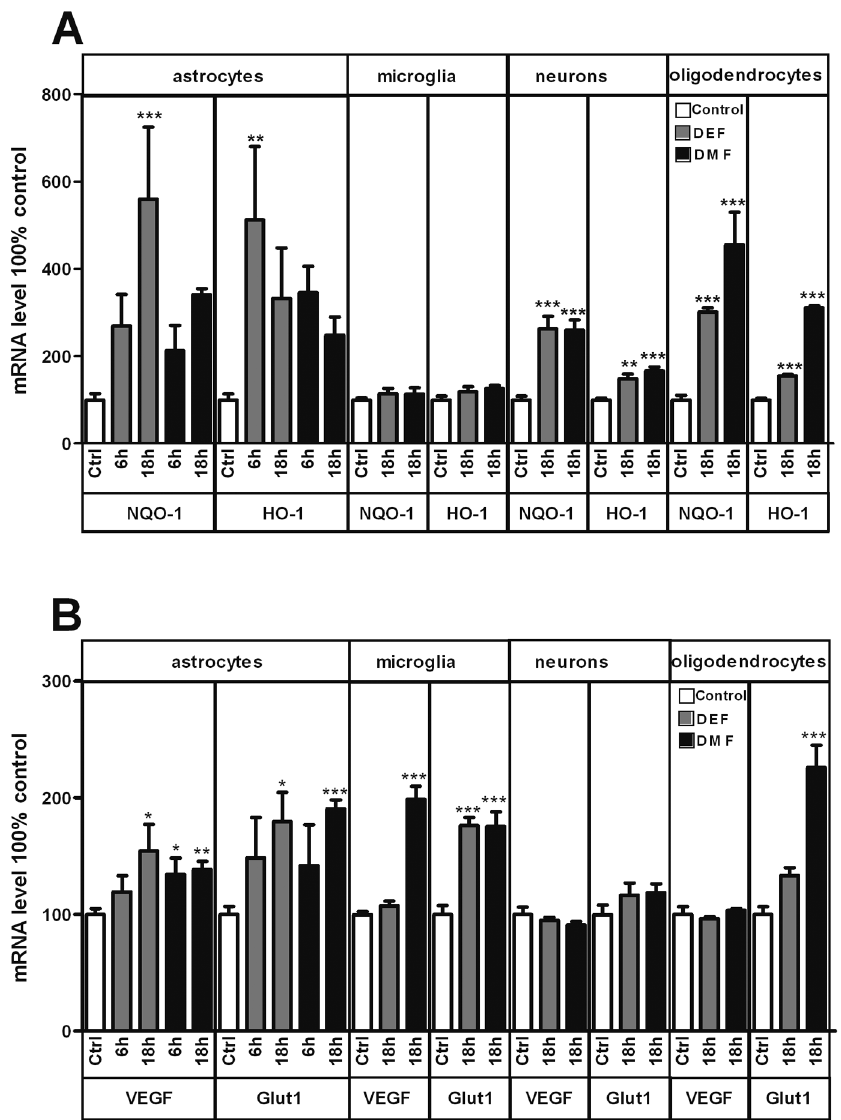
Figure 1. Transcriptional effects of FAEs. ( A ) mRNA levels of NAD(P)H dehydrogenase quinone 1 (NQO-1) and Heme Oxygenase 1 (HO-1), two Nrf2 target genes in astrocytes, microglia, neurons and oligodendrocytes of wild type mice after vehicle (empty columns, Ctrl), or after 6 hours or 18 hours of either 30µM DEF (grey columns, DEF) or DMF (black columns, DMF). Note the robust upregulation of these two genes in all cell types except microglia. ( B ) mRNA levels of vascular endothelial growth factor (VEGF) and glucose transporter 1 (GLUT1), two HIF1-α target genes in astrocytes, microglia, neurons and oligodendrocytes of wild type mice after vehicle (empty columns, Ctrl), or after 6 hours or 18 hours of either 30µM DEF (grey columns, DEF) or DMF (black columns, DMF). FAEs induced the expression of HIF1-α target genes in astrocytes and microglia but not in oligodendrocytes or neurons. *p<0,05; **p<0,01; ***p<0,001; significantly different from corresponding control. Values are mean+/- SEM of n=3 independent